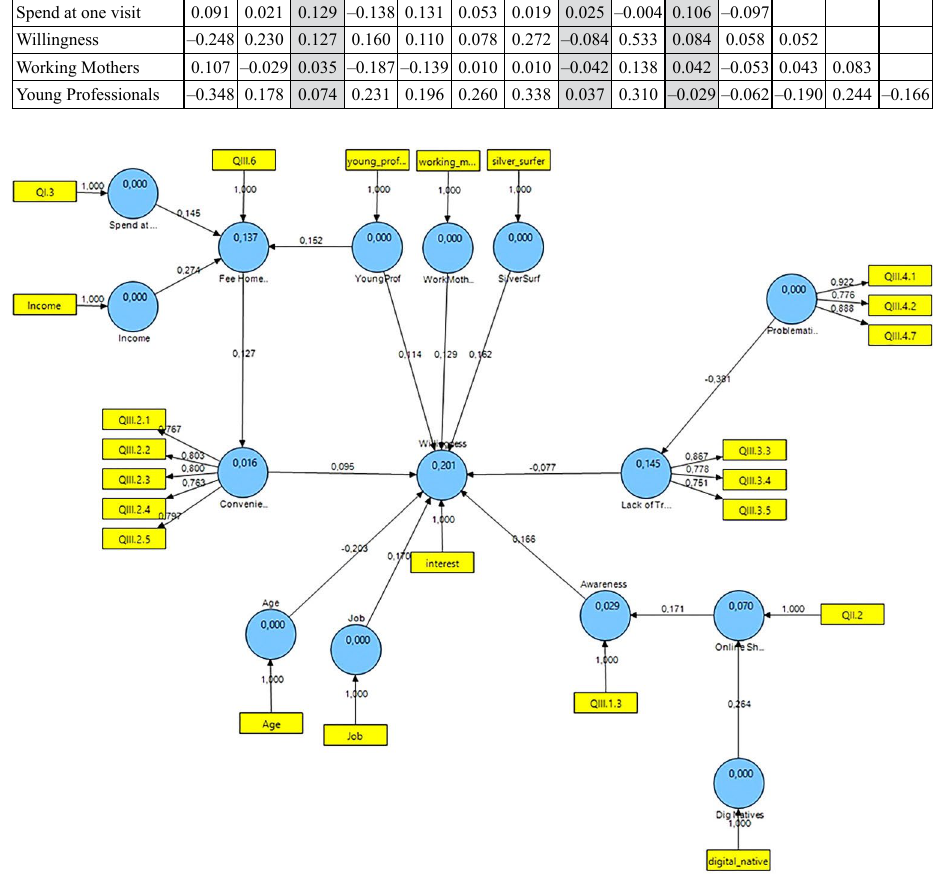
Fig. 1. Graphical path model (PLS-SEM) describing the willingness to shop for groceries